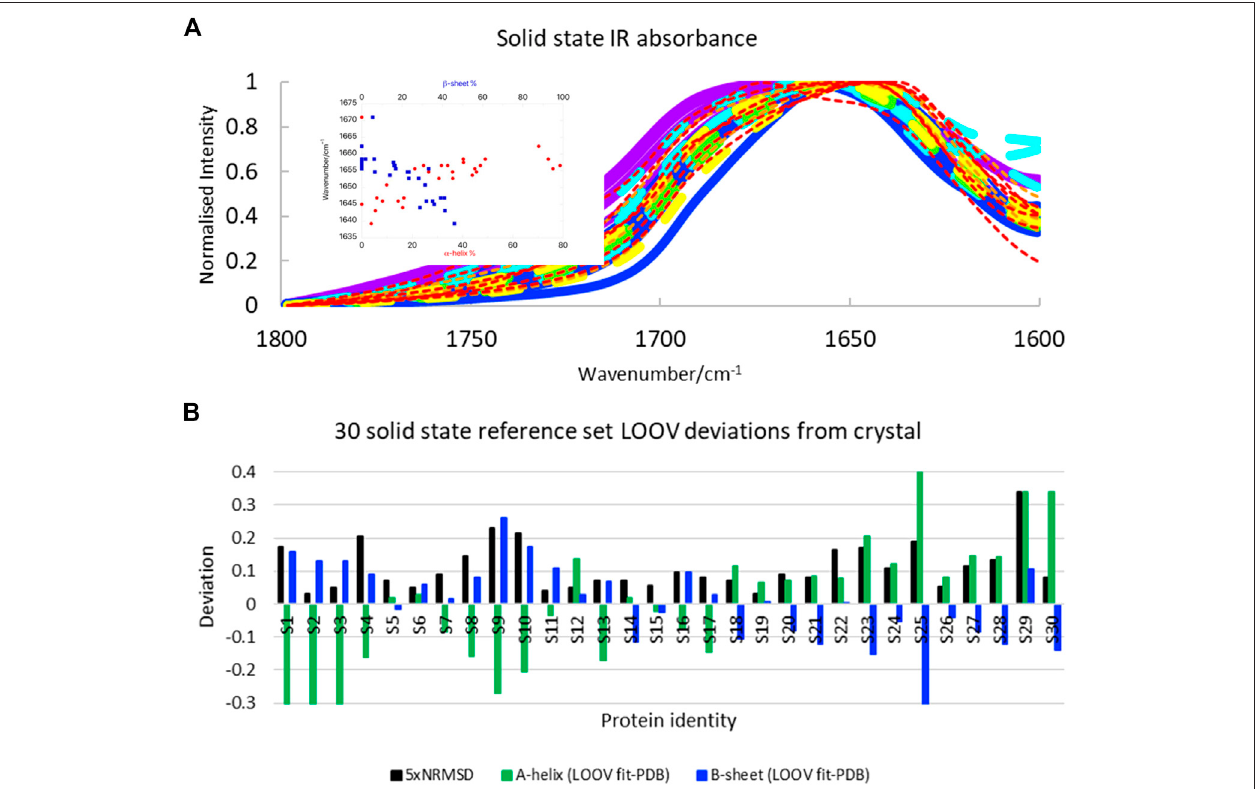
FIGURE 3 | (A) Amide I transmission IR spectra of 30 solid-state proteins normalised to 1. Proteins with α -helix content > 45% are indicated with broad lines and have maxima above 1,650 cm − 1 . Papain and lysozyme are broad dashed lines (see text). Colour coding of spectra is the same as in Figure 1 : > 60% helix purple; 45 – 59% helix blue; 34 – 44% helix turquoise; 26 – 33% helix green; 17 – 25% helix yellow; 10 – 16% helix orange; < 10% helix red. Inset: Amide I maxima plotted against α - helix and β -sheet content. (B) LOOV deviations of SS prediction from PDB structures for α -helix and β -sheet for the Amide I of 30-protein solid-state reference set presented in order of decreasing helix content from left to right (for protein identities see Supplementary Material). Other category deviations are minus the sum of helix and β -sheet deviations.